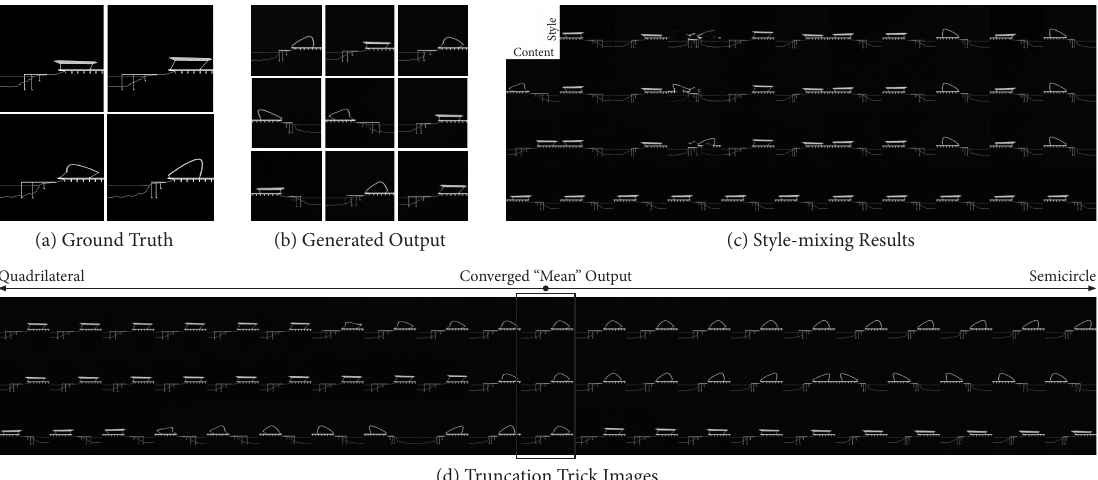
Figure 6. These are the training processes and results of designed single drawing variations: ( a ) Example of input data. ( b ) Selected output fake images. ( c ) Contents, styles, and mixed results. ( d ) Continuing transforming images